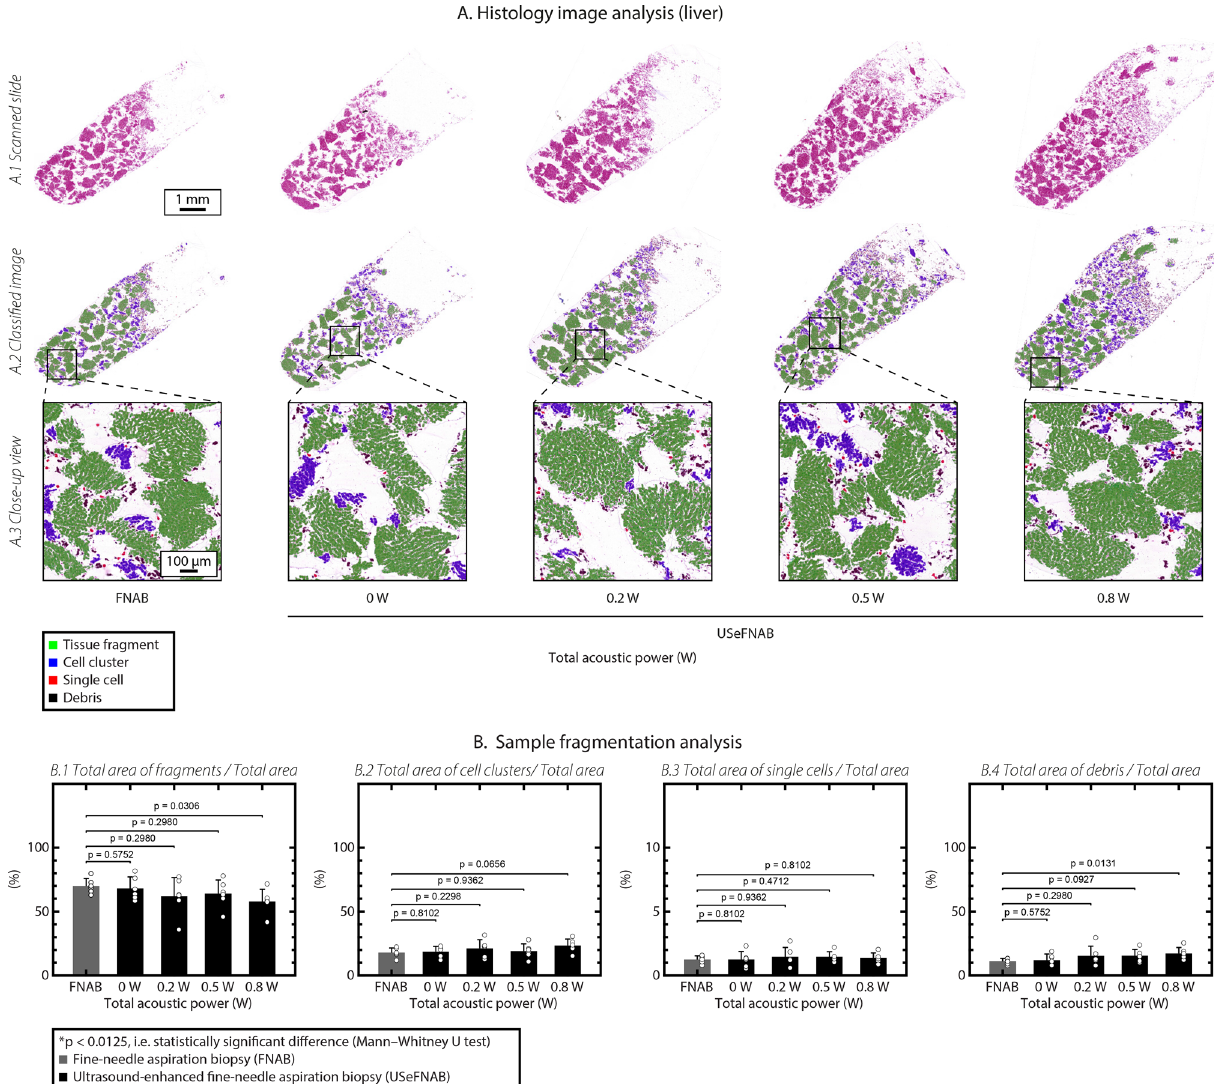
Figure 5. ( A ) Computer assisted evaluation of tissue fragmentation in liver biopsy samples. ( A (1)) represents exemplary histological images used for the analysis. ( A (2,3)) show the classified images where tissue fragments, cell clusters, single cells and debris are detected and highlighted in green, blue, red and black, respectively. ( B (1)) The relative total area of tissue fragments, ( B (2)) cell clusters, ( B (3)) single cells, ( B (4)) debris pieces were calculated and used for statistical comparison between the FNAB and USeFNAB groups. In the bar charts, the bar height represents the mean of the data set and the error bar indicates the standard deviation. Individual data points are shown as white-filled